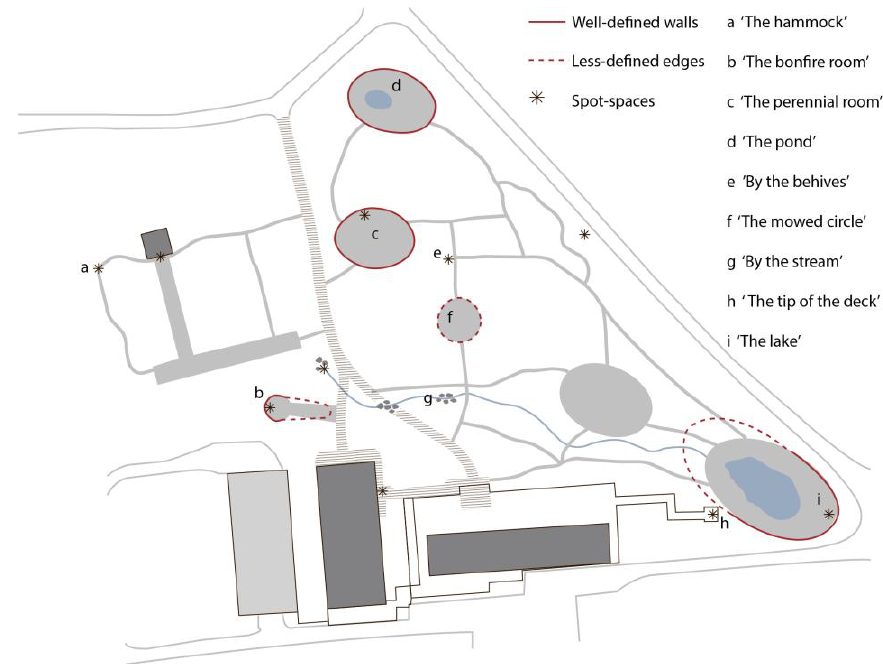
Figure 8. The spaces experienced as most distinctive, and spot-spaces identified by means of the landscape analysis, observations, interviews, and logbooks.